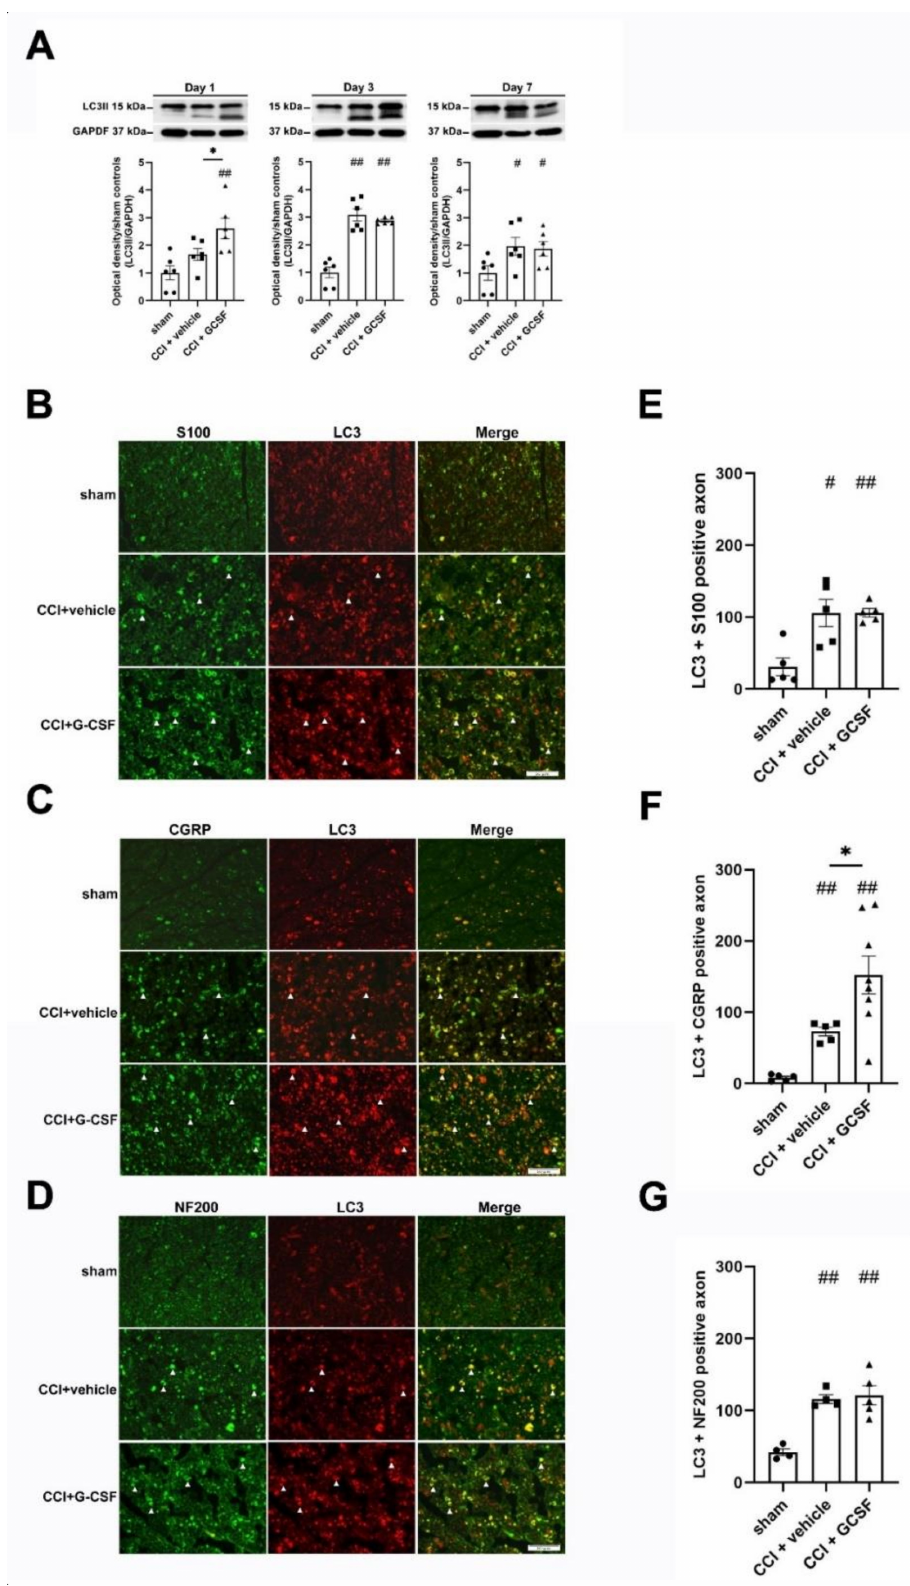
Figure 3. G-CSF upregulated autophagy in the injured sciatic nerve on the 1st day after nerve injury. ( A ) Western blot analysis revealed significantly higher LC3II protein levels in the injured sciatic